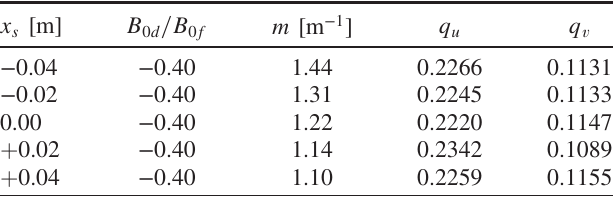
TABLE IV. Parameters for the representative orbits in Fig. 8.